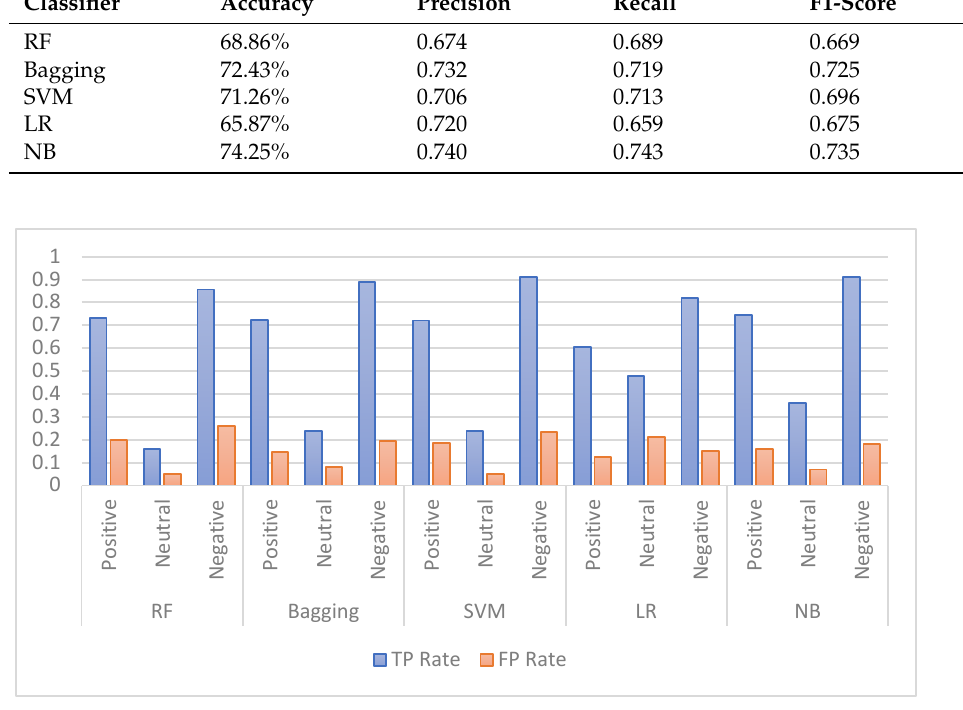
Figure 5. True-positive rate (TP Rate) and false-positive rate (FP Rate) of ML models with original sentiments using BoW.